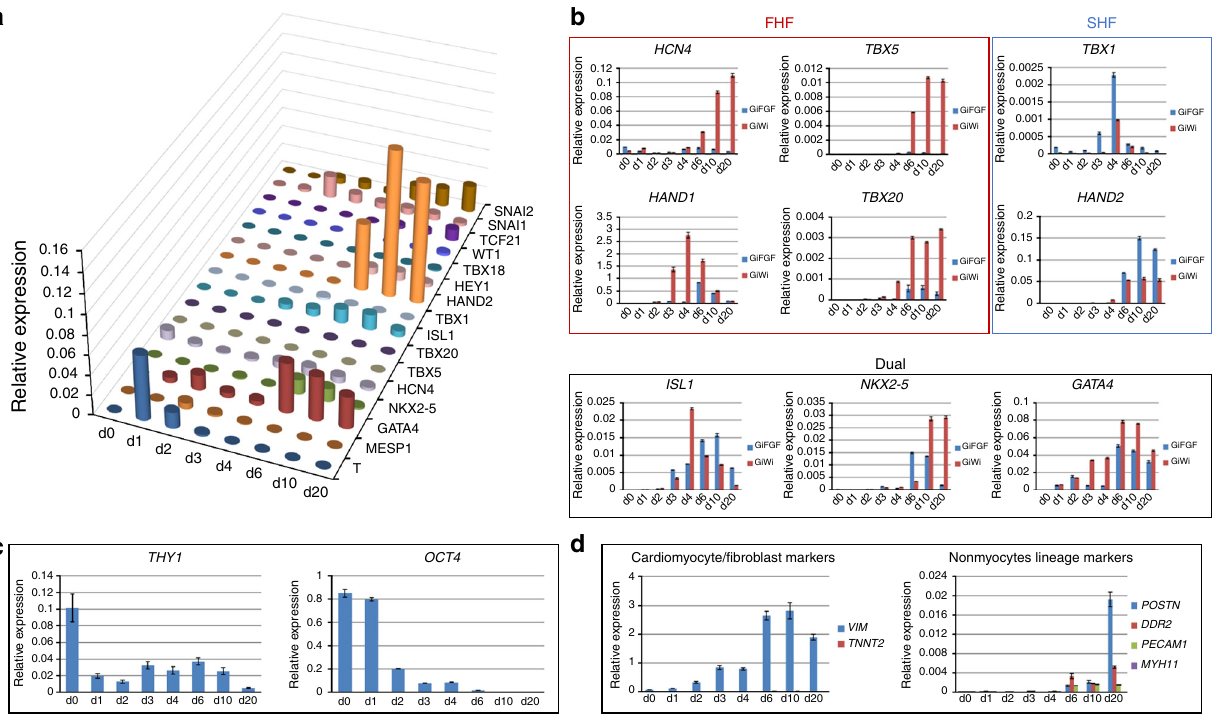
Fig. 3 Analysis of cardiogenic gene expression during GiFGF protocol. a qRT-PCR showing the expression and hierarchy of transcription factors in the time course of the GiFGF protocol (day 0 – 20). b qRT-PCR showing the expression patterns of the transcription factors in FHF and SHF in the GiFGF protocol in comparison with the GiWi protocol. c qRT-PCR showing the expression time course of CD90 and OCT4 in GiFGF protocol (day 0 – 20). d qRT-PCR showing the expression of markers for fi broblasts ( VIM , POSTN , and DDR2 ), cardiomyocytes ( TNNT2 ), and nonmyocyte lineages ( PECAM1 and MYH11 ) in the time technical replicates for each point. Data are mean ± SEM. The data are from DF19-9-11T hiPSC